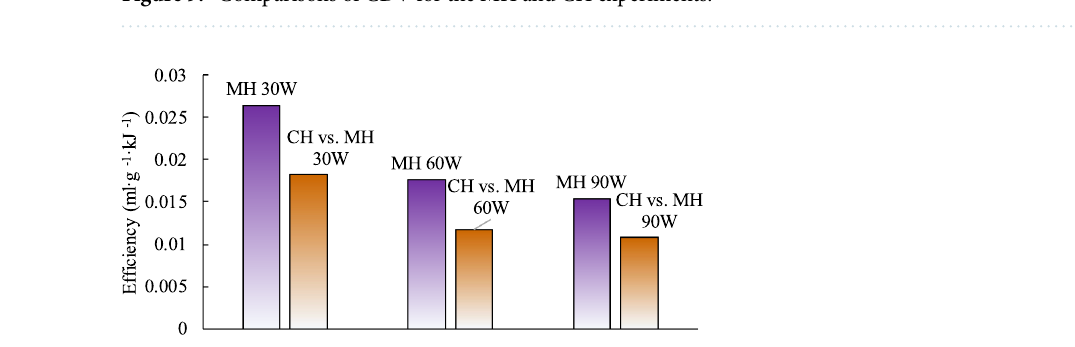
Figure 9. Comparisons of CDV for the MH and CH experiments.